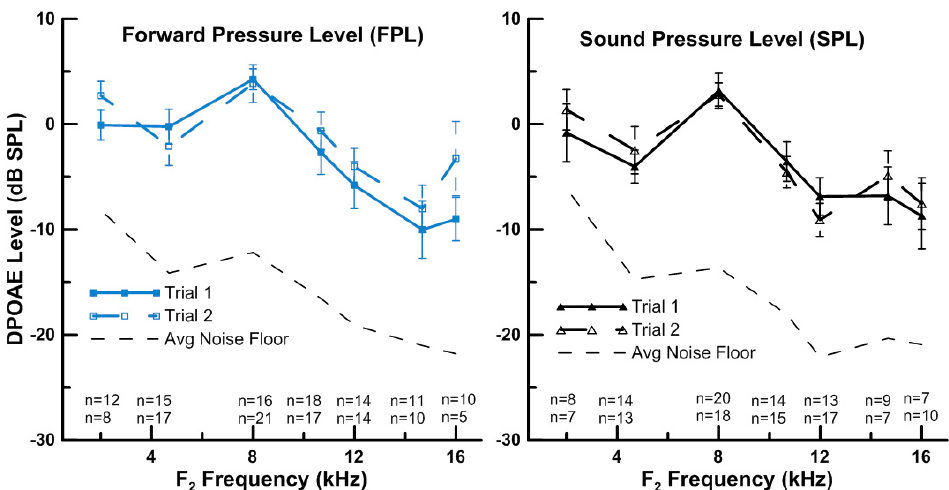
Figure 2. Average distortion-product otoacoustic emissions (DPOAE) levels across frequencies tested using either Forward pressure level (FPL) ( left panel ) or sound pressure level (SPL) ( right panel ) for calibration in newborns with present DPOAEs. The solid lines represent trial 1 and the long-dashed lines represent trial 2. Standard errors are shown. The short-dashed lines are the average noise floor for both trials. The number of newborns ( n ) with present DPOAEs for each frequency are indicated, where the top value is for trial 1 and the bottom value is for trial 2.